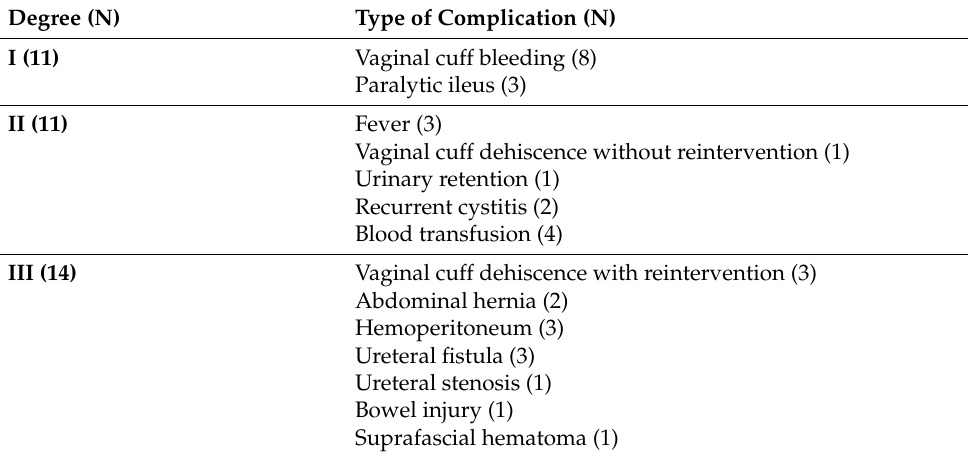
Table 2. Details of postoperative complications using Clavien–Dindo